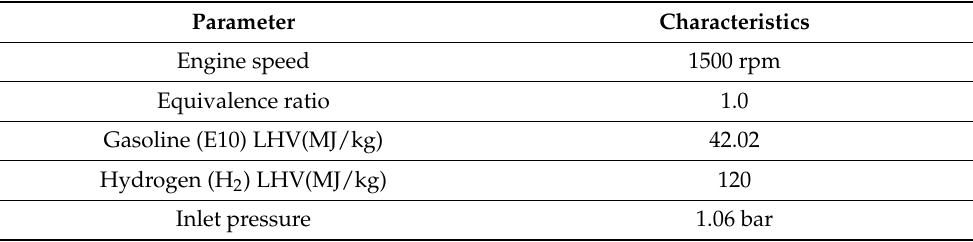
Table 4. Operational performance of engine. Reproduced with permission from Aghahasani, M., etc., Energy Convers Manag.; published by Elsevier, 2022